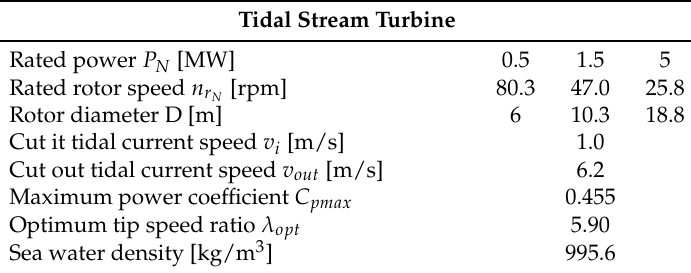
Table 1. Modeling parameters of the tidal stream turbine